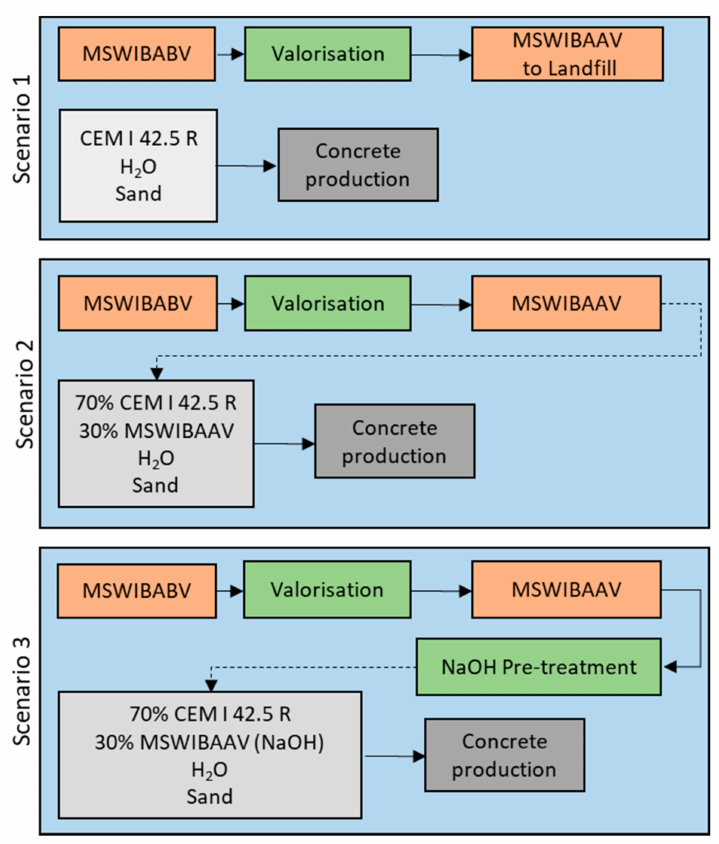
Figure 3. LCA assumptions of three different methods for MSWIBA treatment (MSWIBA BV – MSWIBA before valorization; MSWIBA AV –MSWIBA after